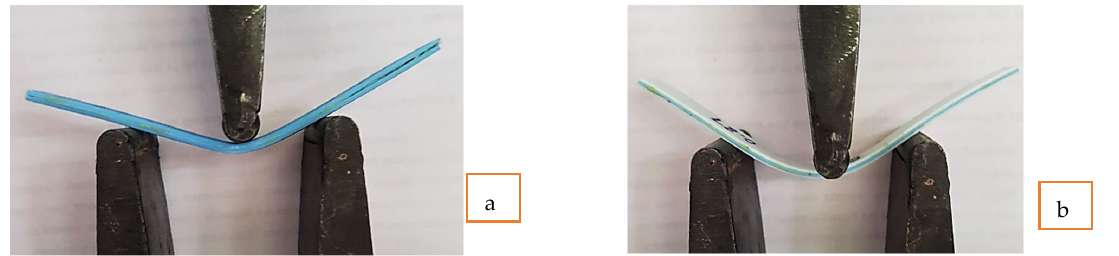
Figure 8. Flexural testing of specimens ( a ) V-shaped bending for ATA specimen (S.No. 4). ( b ) U-shaped bending of the specimen made of TAT material.